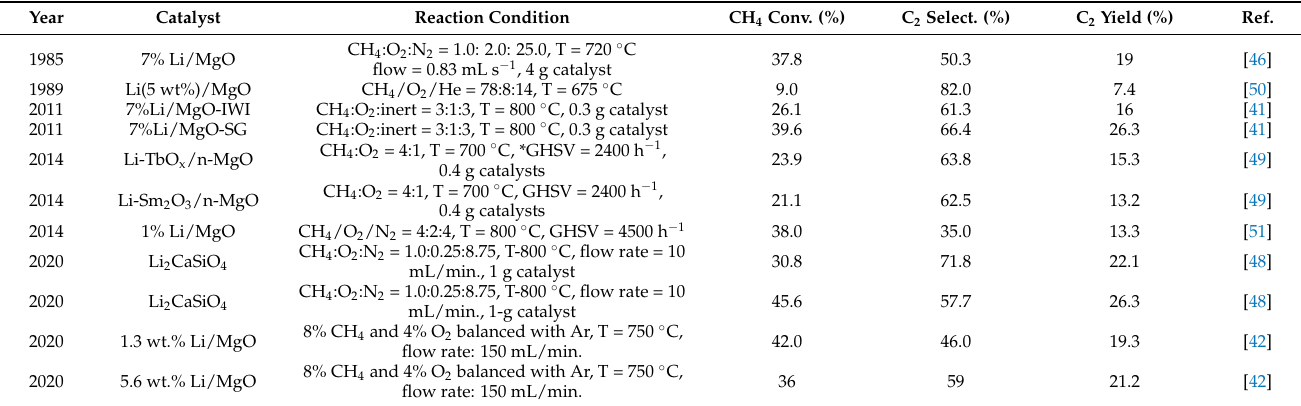
Table 1. OCM reaction over various Li supported/doped